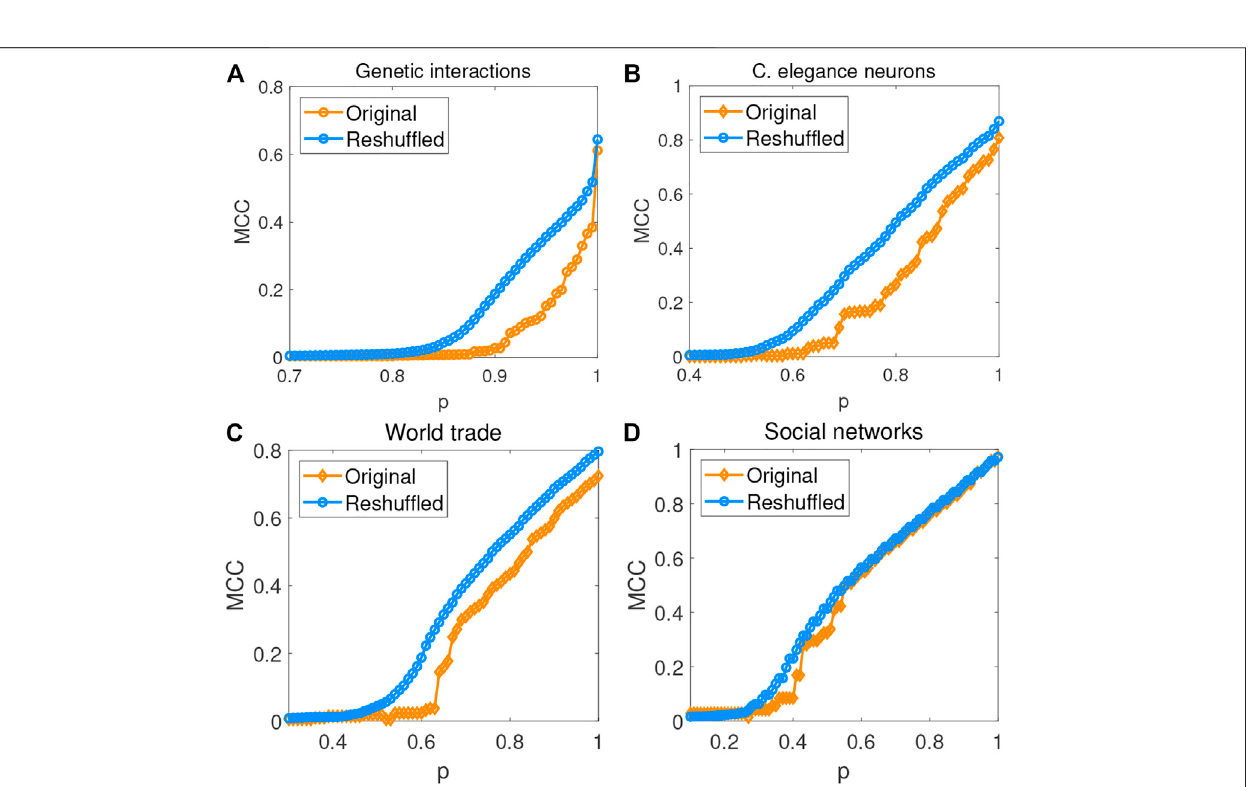
FIGURE 5 | The relative size of the MCC against the remaining fraction p of nodes remaining in the system for real interdependent directed networks, including genetic interactions networks (A) , C.elegance neurons networks (B) , world trade networks (C) , and social networks (D) . The orange line and the blue line represent the results of real-world networks (Original) and their reshuf fl ed counterparts (Reshuf fl ed), respectively.